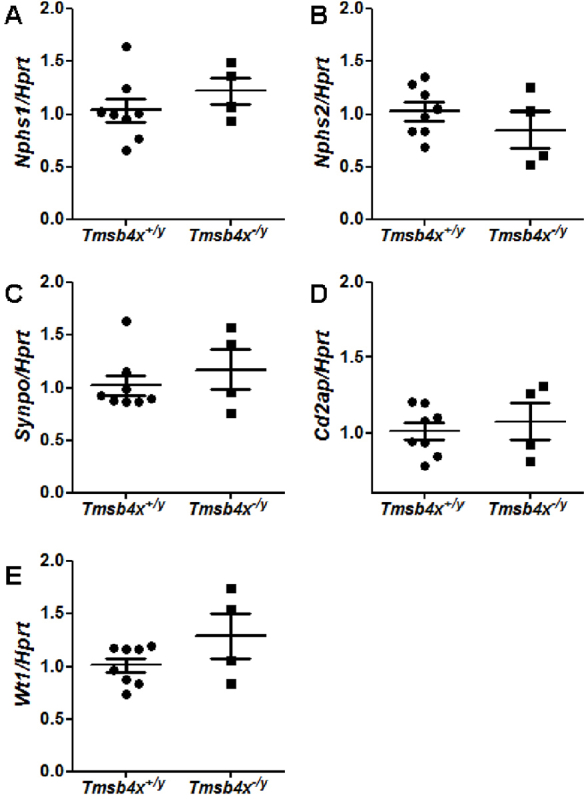
Quantification of nephrin (Nphs1;A), podocin (Nphs2; B), synaptopodin (Synpo; C), cd2 associated protein (Cd2ap) (D) and Wilms tumor 1 (Wt1) (E) mRNA in whole-kidney homogenates of Tmsb4x+/y (n = 8) and Tmsb4x−/y (n = 4) mice by quantitative reverse transcriptase polymerase chain reaction. Data are presented as mean ± SEM.